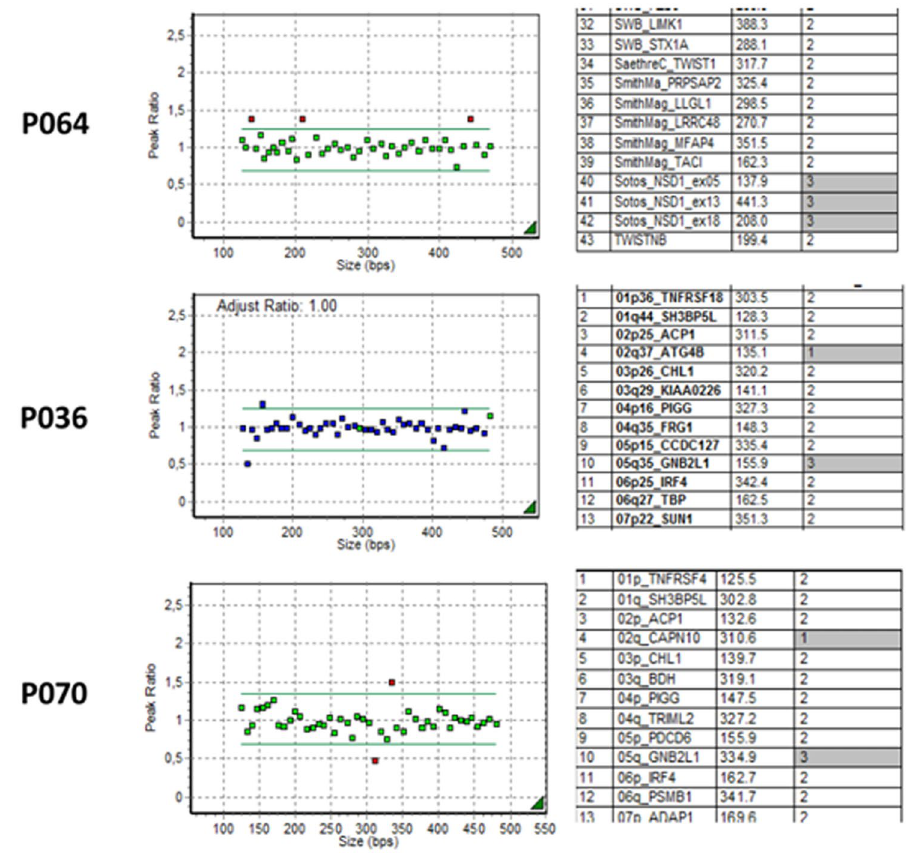
Figure 1. MLPA showing 5q35.3 microduplication and 2q37.3